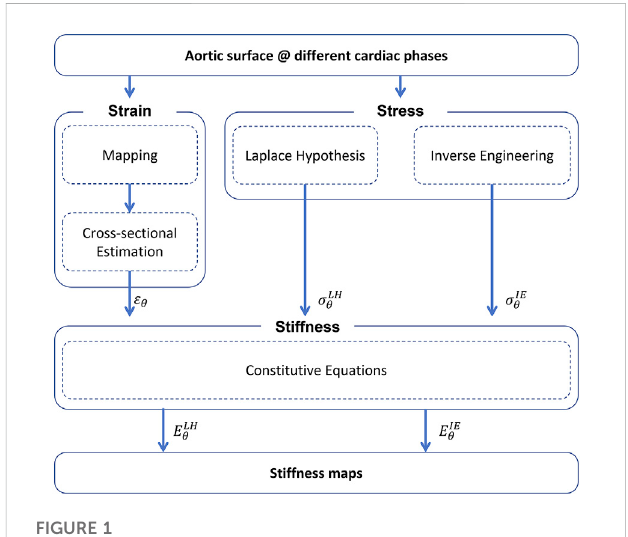
FIGURE 1 Summary of the work fl ow for the non-invasive stiffness estimation ( ε θ — circumferential strain, σ LH , IE θ — circumferential stress estimated with Laplace Hypothesis (LH) or with inverse engineering (IE) approach, E LH , IE θ — circumferential stiffness estimated with Laplace Hypothesis (LH) or with inverse engineering (IE)